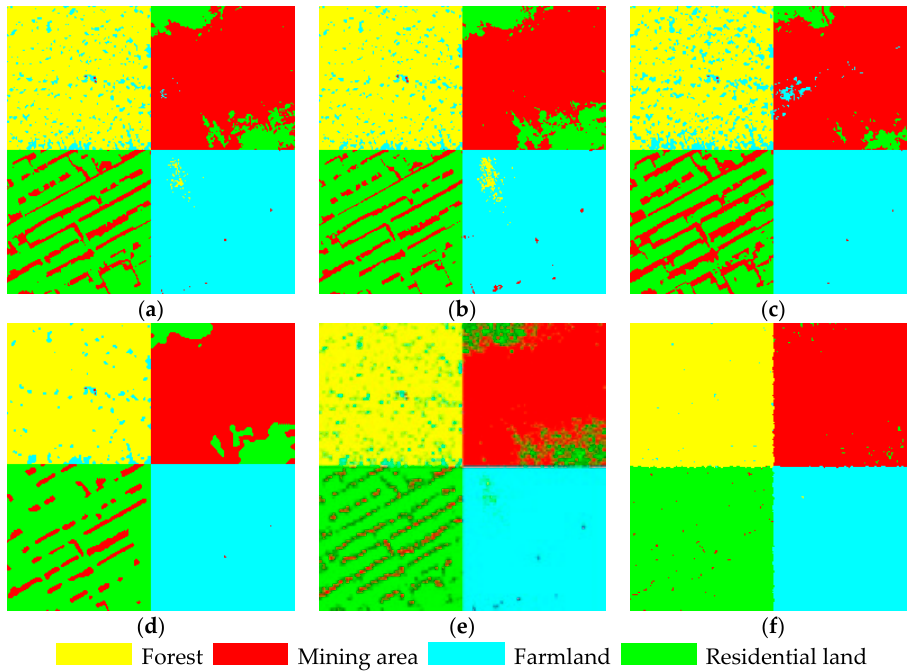
Figure 9. Quick Bird synthetic image classification results. ( a ) Gauss membership function method; ( b ) Maximum likelihood method; ( c ) Fuzzy C-means (FCM); ( d ) Hidden Markov Random Field (HMRF-FCM); ( e ) Weighted average method; and, ( f ) Neighborhood weighted average method.